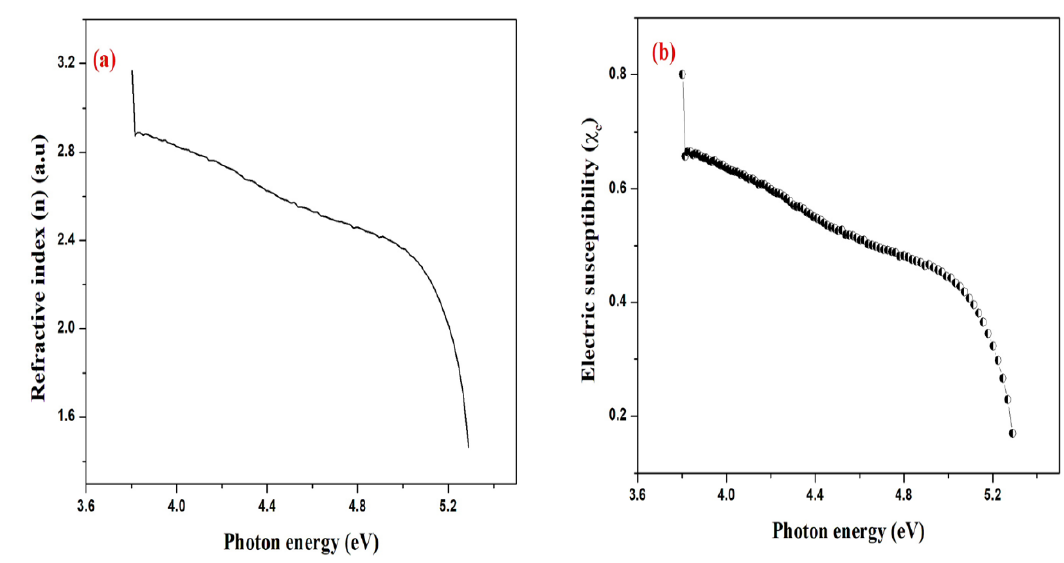
Figure 8. Photon energy versus ( a ) refractive index and ( b ) electric susceptibility.